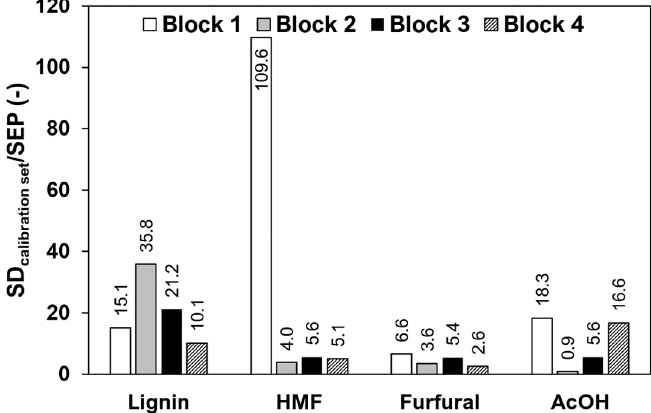
Figure 4. Average SEP values derived by rdCV divided by the standard deviation of the concentrations used in the calibration sets from raw data.